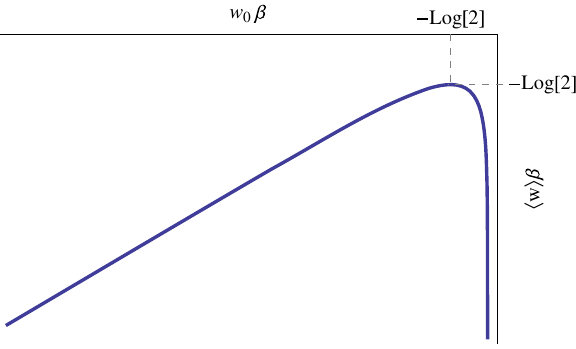
FIG. 2. As a simple example of the second law equality, one can think of single qubit erasure. In the limit of perfect erasure, the second law equality reads in this case e β w 0 þ e β w 1 ¼ 1 , and the w w average work spent is h w i ¼ 1 0 þ 1 Þ . Here, we show 2 ð the trade-off between w 0 and h w i for such perfect erasure. The optimal work value for erasure is the usual Landauer cost at w w − T log 2 . As seen in Eq. (53), perfect or near-perfect 0 ¼ 1 ¼ erasure requires the work cost to fluctuate